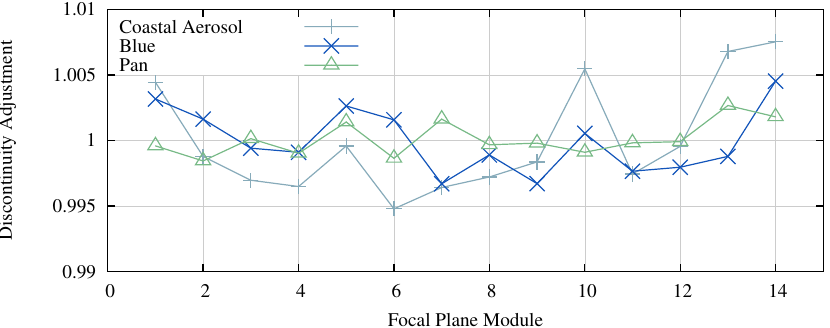
Figure 9. The adjustments made to the PSC gains to account for discontinuities between FPMs as determined from the solar diffuser data. Only the coastal aerosol, blue and pan bands were adjusted.